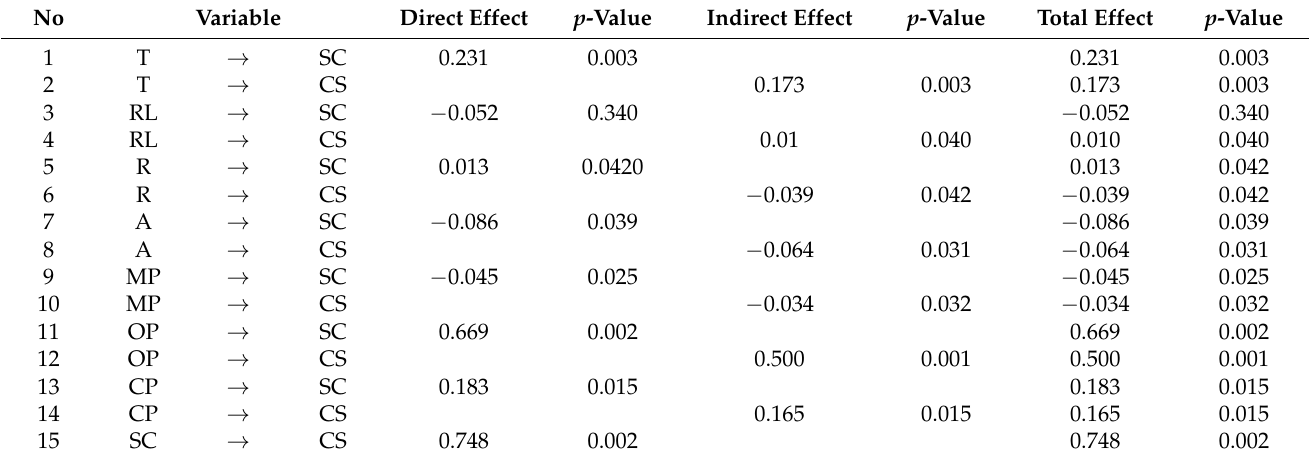
Table 6. Direct, Indirect, and Total